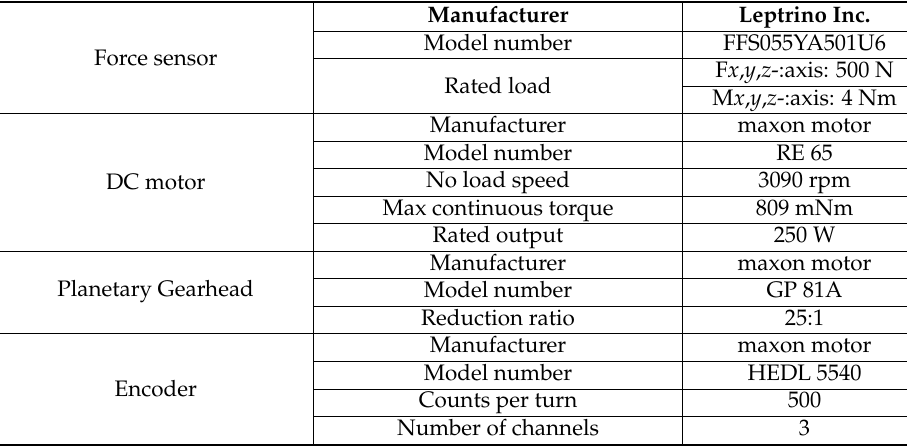
Table 1. Specifications of the training robot.